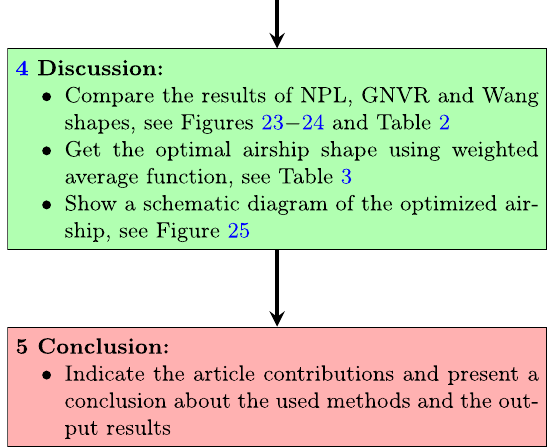
Fig. 1 Airship optimal shape design flowchart